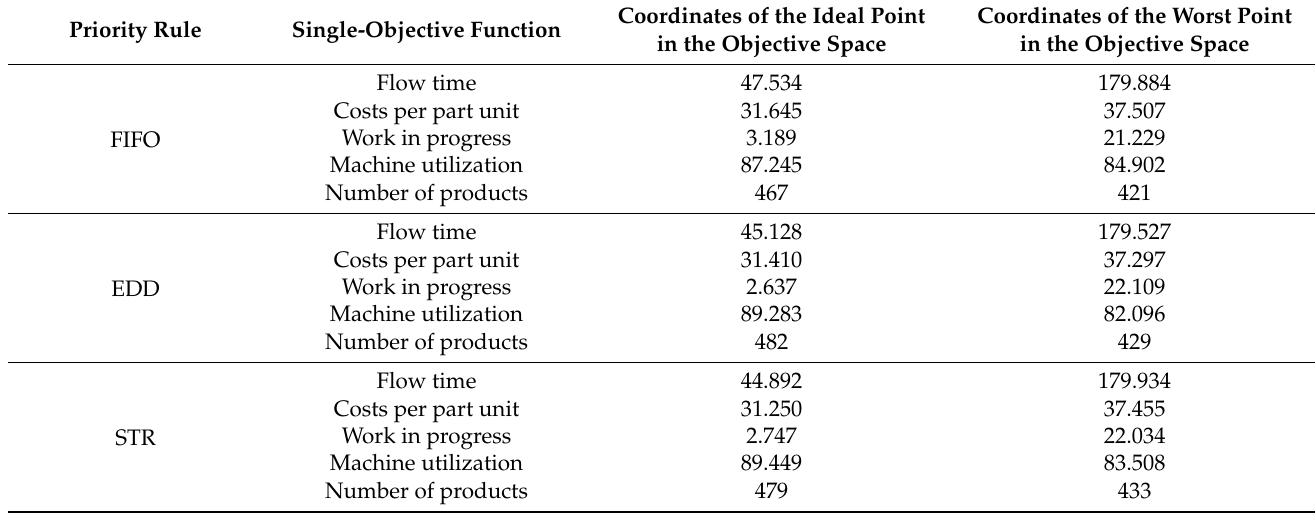
Table 6. Results of single-objective optimization of production objectives. FIFO: First In First Out; EDD: Earliest Due Date; STR: Slack Time